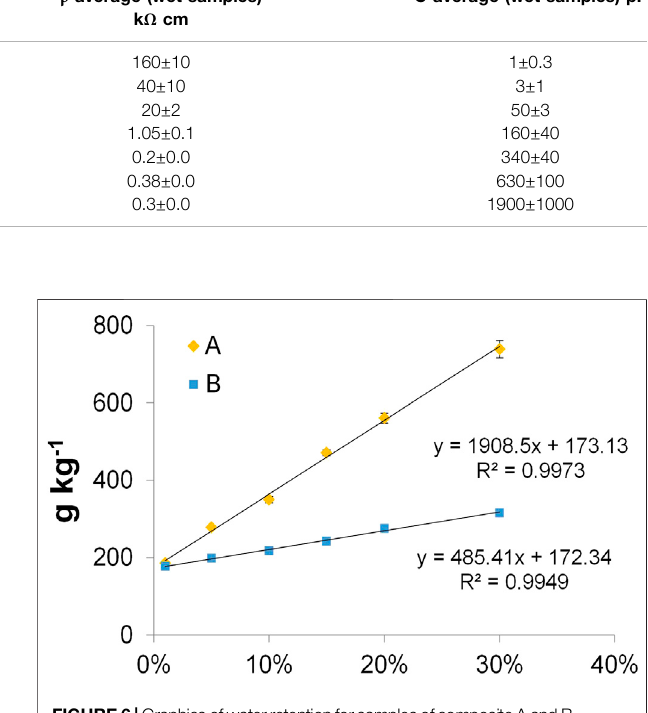
TABLE 3 | Electric resistivity ( ρ ) and capacitance (C) estimated on dry and wet samples of composite A with a thickness of 8 mm. Biogenic Carbon (%)